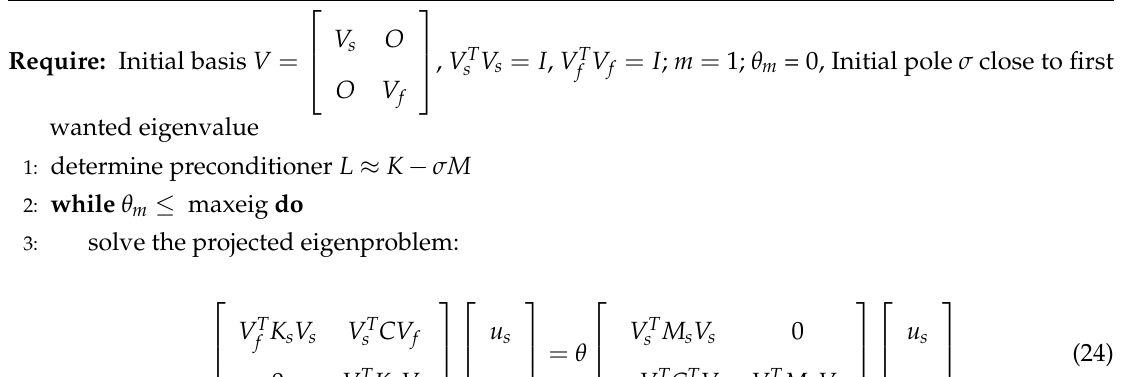
Algorithm 2 Structure-preserving nonlinear Arnoldi method for fluid–solid eigenvalue